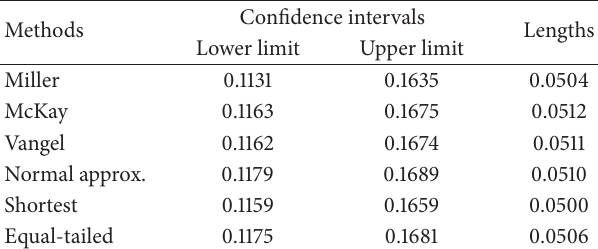
Table4:The95%confidenceintervalsforthecoefficientofvariation of the weight of one-month old